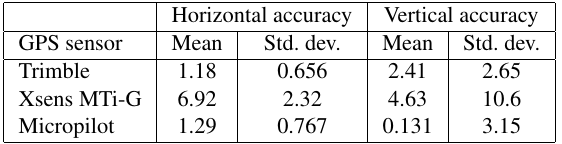
Table 1: Accuracy of onboard GPS receivers compared to Trim- ble GPS data post processed with GrafNav. The mean and stan- dard deviations have been calculated for data recorded throughout the whole flight. All figures are in meters.